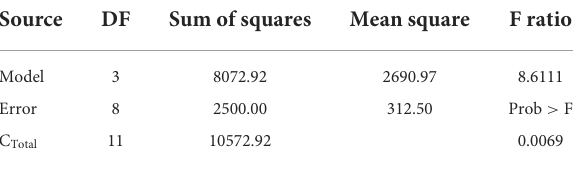
TABLE 4 Variance analysis of experimental design results.